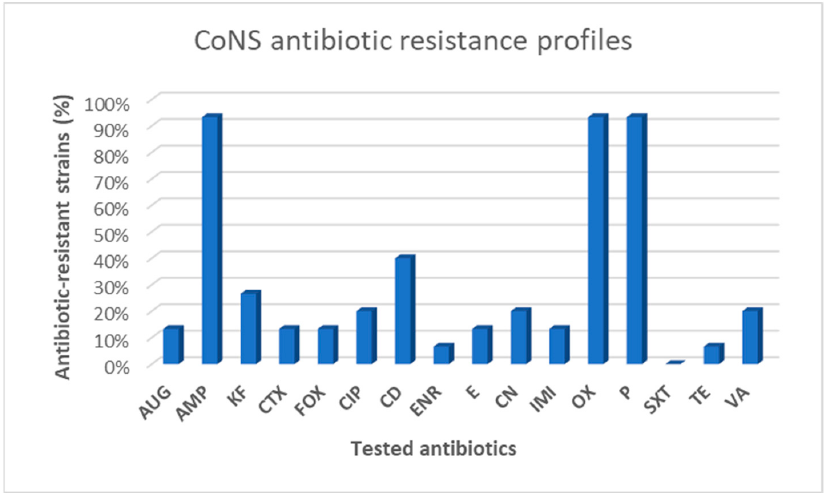
Figure 2. Antimicrobial resistance profiles of CoNS isolated from wild boars. Antibiotics: AUG: amoxicillin ‐ clavulanate; AMP: ampicillin; KF: cephalothin; CTX: cefotaxime; FOX: cefoxitin; CIP: